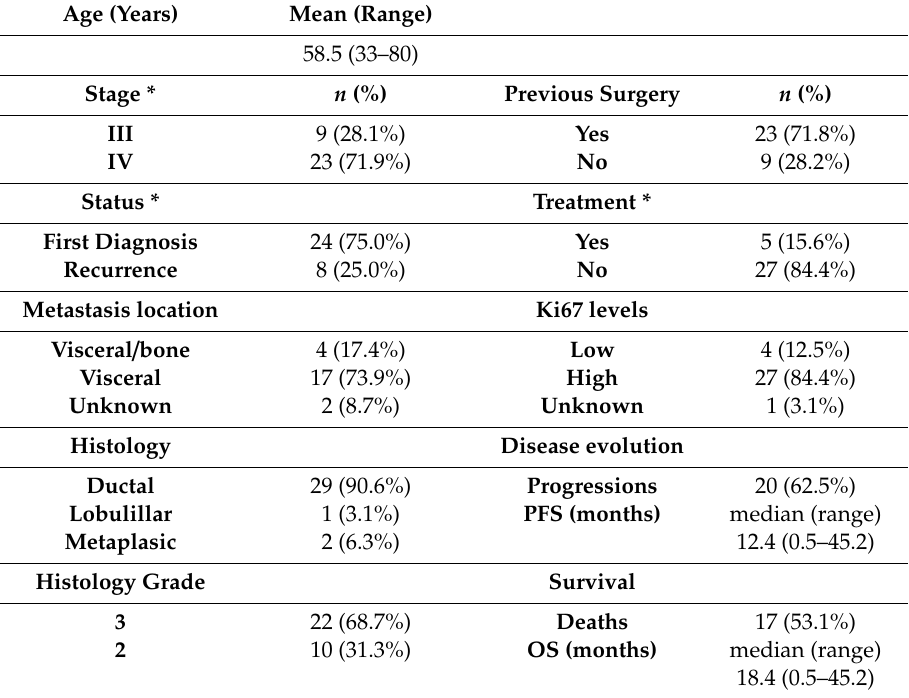
Table 1. Clinico-pathologic characteristics of the cohort of patients with triple-negative breast cancer